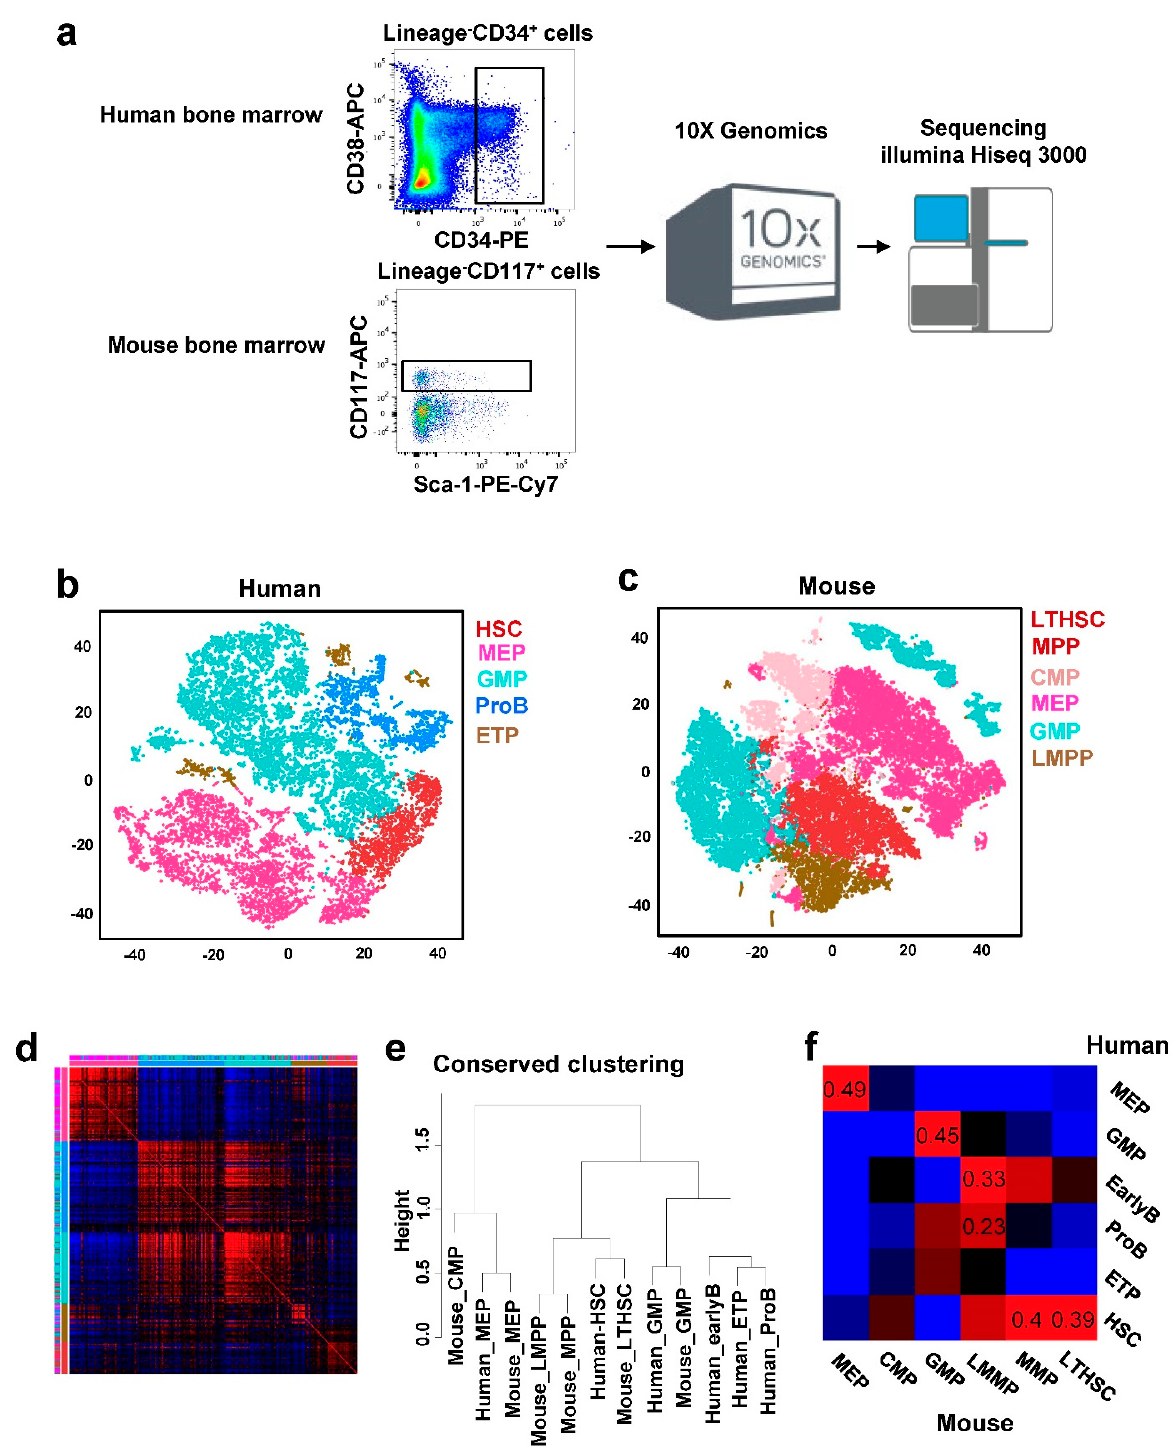
Figure 1. ( a ) Schematic overview of the study design. ( b ) A tSNE plot of single-cell gene expression of human HSPCs. ( c ) A tSNE plot of single-cell gene expression of mouse HSPCs. ( d ) Correlation of expression between human and mouse orthologous cell-type specific genes (red indicates high correlation and blue indicates low correlation). Cell types of species (inner was for human) were marked by the colors defined in ( b ). Conservation of homologous genes between species was evident. ( e ) The phylogenetic tree of human and mouse cell populations. Average expression across human–mouse homologous genes was calculated for cell types of human and mouse, and the distance between expression patterns for different cell types was used for hierarchical clustering. ( f ) Correlation of expression levels of homologous genes in human and mouse cell